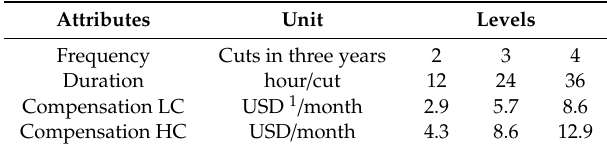
Table 2. Attributes and levels of the